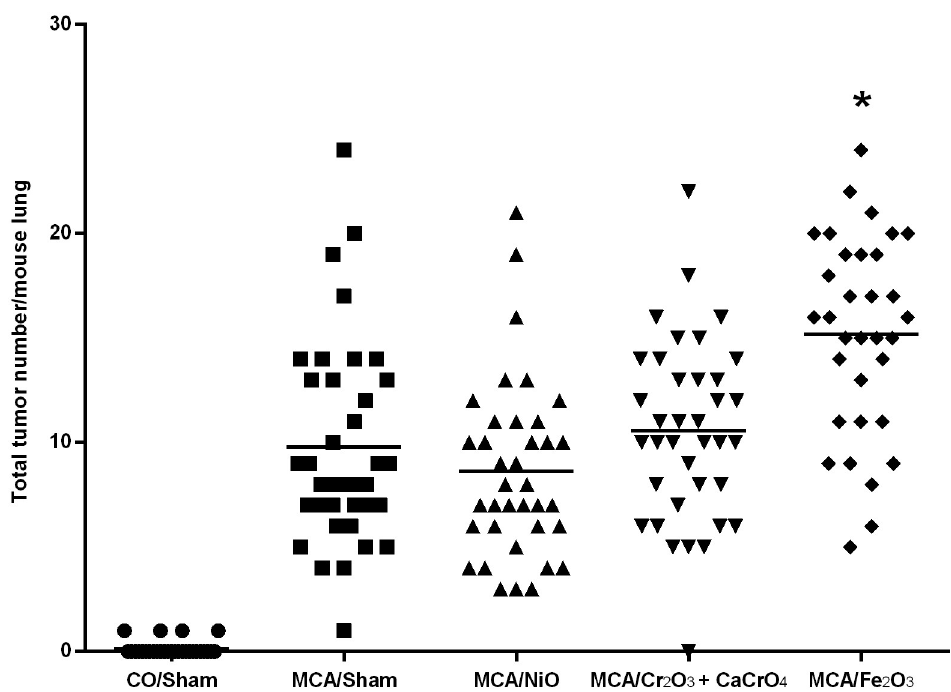
Fig 8. Total tumor number per mouse lung following exposure to CO or MCA and a metal oxide or sham. Bars represent lung tumor multiplicity (mean tumor number/mouse lung and includes mice with no tumors) for each group. � p < 0.0001 compared to